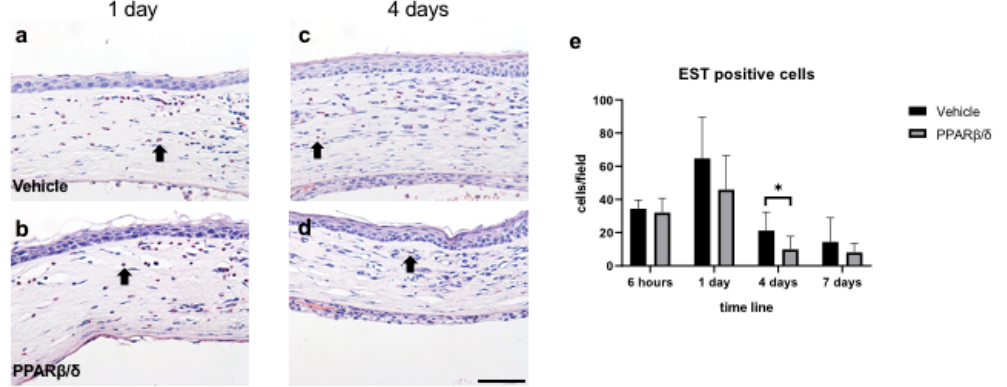
Figure 2. EST staining. EST staining was performed to examine neutrophil infiltration. Vehicle group ( a , c ) and PPAR β / δ group ( b , d ) in the corneal limbus on day 1 and day 4 after injury (black arrows: EST-positive cells). Bar, 50 µ m. Fewer EST-positive neutrophils were present in the PPAR β / δ group than in the vehicle group ( e ). Data are presented as mean ± SD ( n = 8) * p < 0.05.